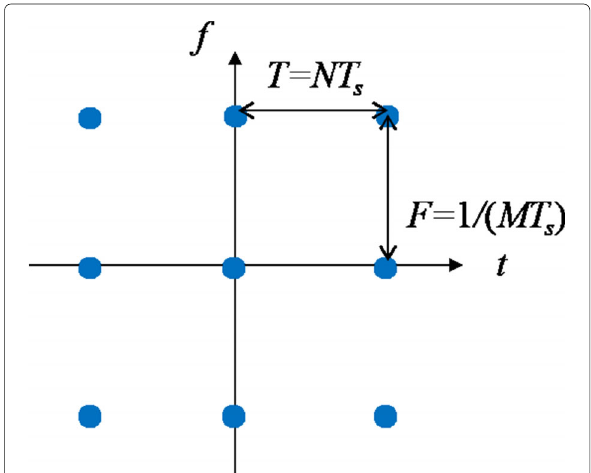
Fig. 1 Rectangular lattice for QAM systems